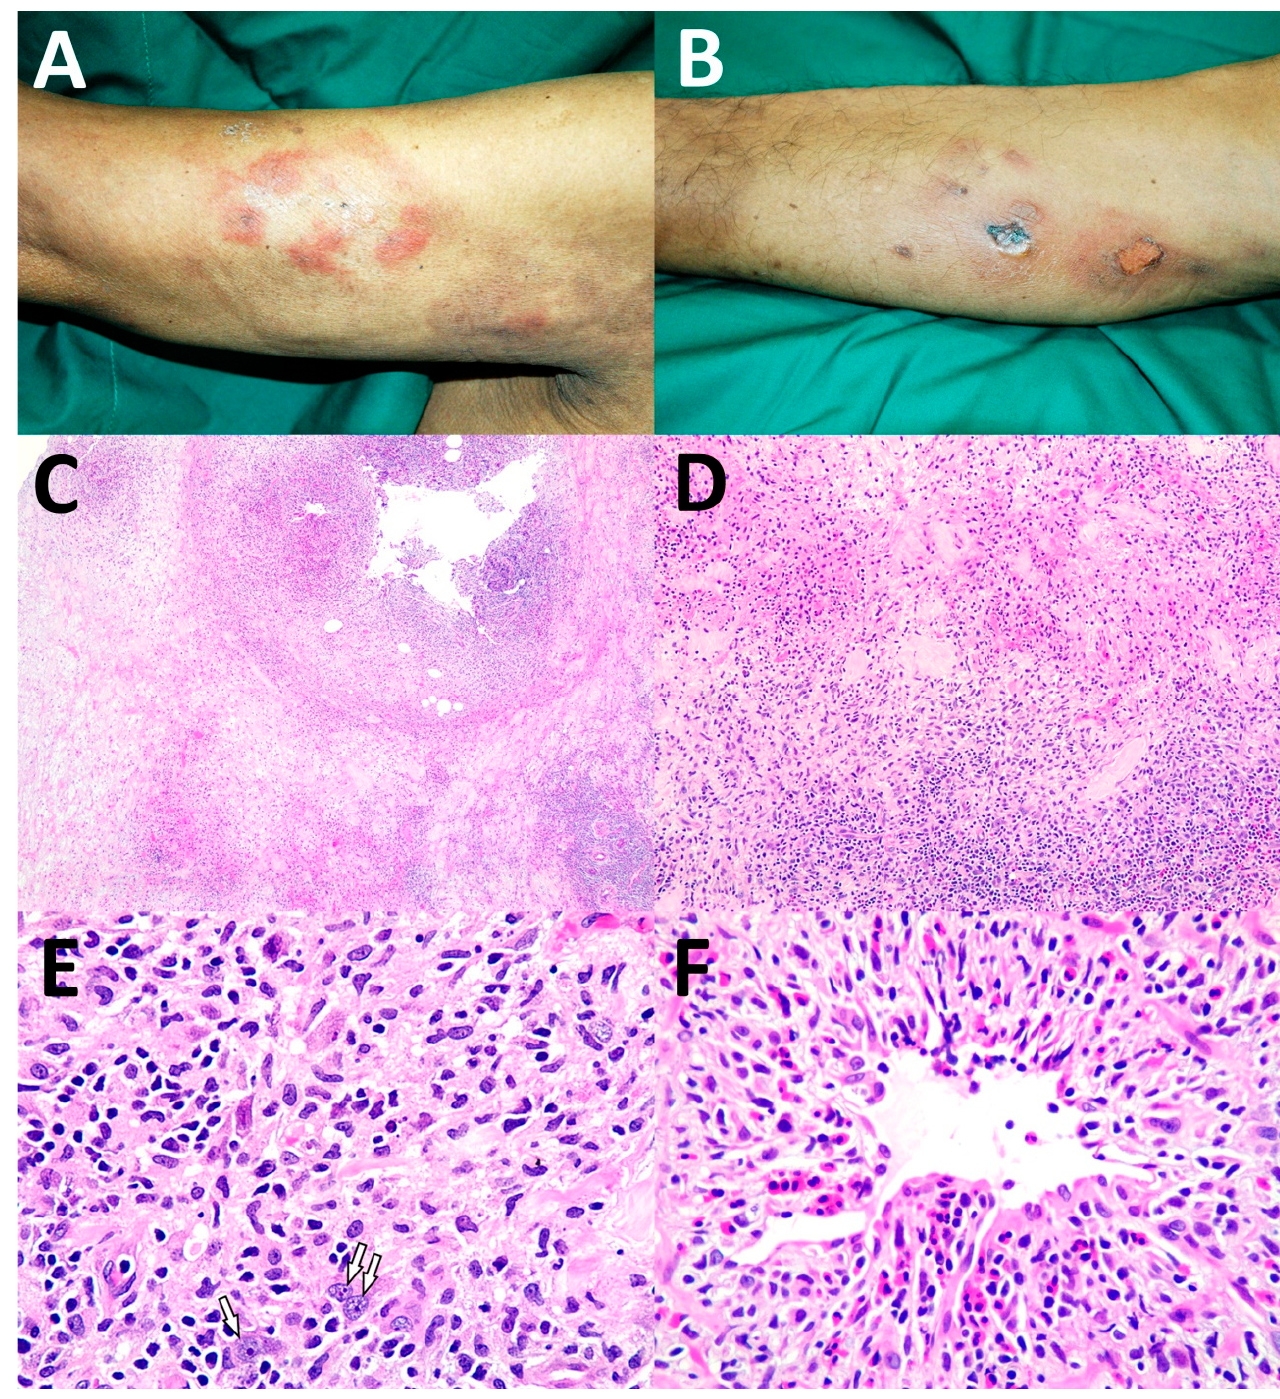
Figure 4. Granulomatous dermatitis pattern: ( A ) erythematous plaques on right arm; ( B ) nodules and plaques with ulcer on left leg; ( C ) lobular panniculitis with necrosis (H&E, original magnification ×100); ( D ) mixed infiltration of histiocytes, lymphocytes, and eosinophils (H&E, original magnification ×100); ( E ) granulomatous inflammation with few scattered atypical cells (white arrows) (H&E, original magnification ×400); ( F ) angioinvasion by atypical lymphoid cells and eosinophils (H&E, original magnification ×400).